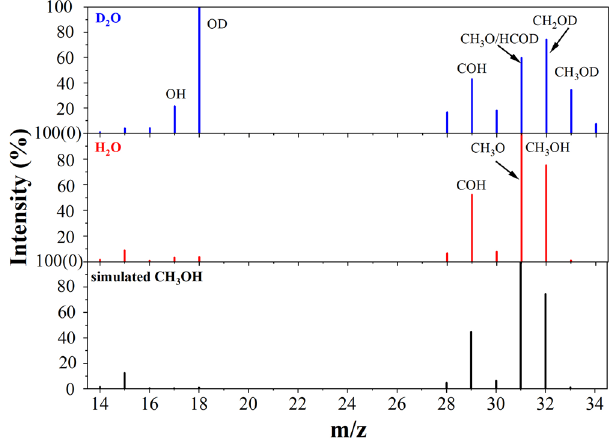
Fig. 5 GC-MS spectra of methanol formed using H 2 O and D 2 O. The GC- MS spectra reveal that most of the produced methanol is CH 3 OD and that few molecules are CH 3